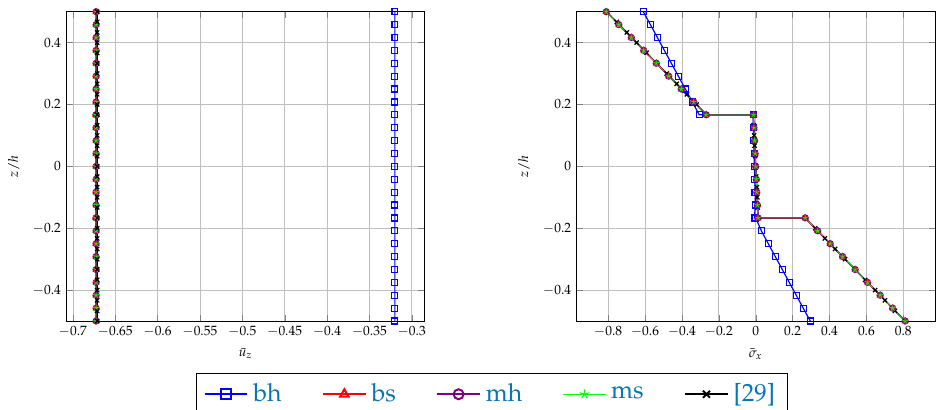
Figure 5. Example 1: Plots of dimensionless deflection ¯ u z and stress component ¯ σ x in the middle of the plate with a / h = 100, along the plate thickness calculated by FEM23 with different types of boundary conditions.